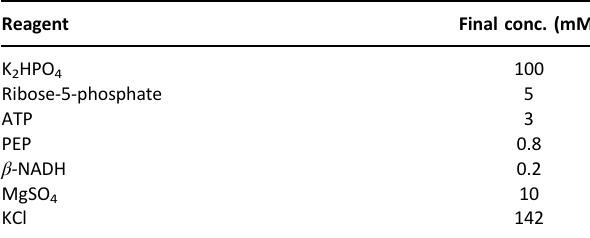
Table 5. Reagents for PRPPS